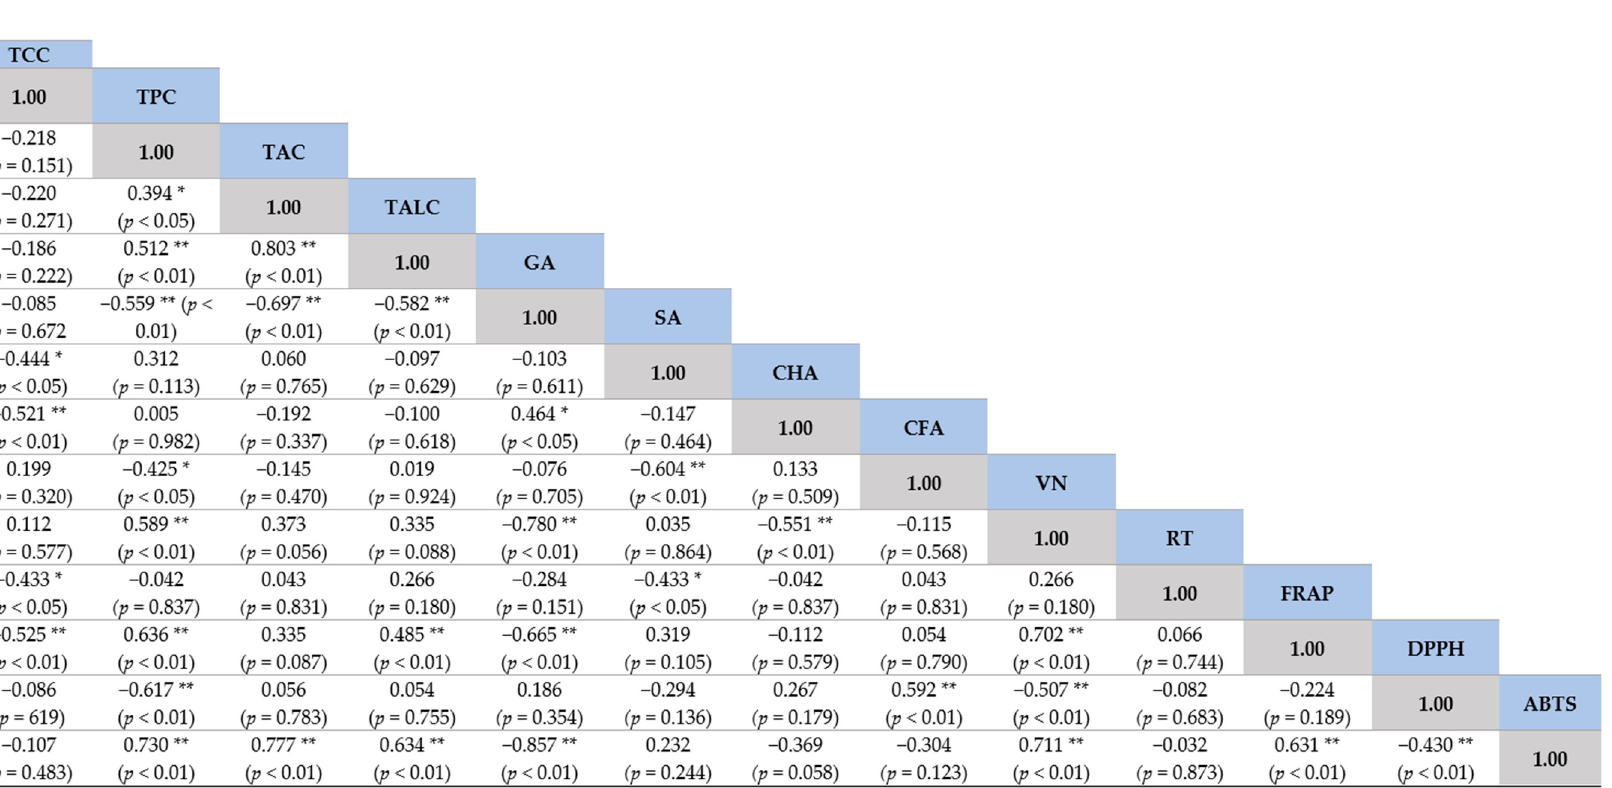
Figure 6. Correlation coefficient (r) between the phytochemicals (TCC, TPC, TFC, TALC, TAC, GA, SA, CHA, CFA, VN, and RT) in different sprouts with antioxidant capacity (DPPH, ABTS, and FRAP). If the r value is close to +1 or − 1, it indicates a strong positive relationship or an inverse relationship, respectively. If r is near 0, it indicates a weak or no relationship. * Correlation is significant at p < 0.05. ** Correlation is significant at p < 0.01. Abbreviation: TCC = total chlorophyll content, TPC = total phenolic content, TAC = total anthocyanin content, TALC = total alkaloid content, TFC = total flavonoid content, GA = gallic acid, SA = syringic acid, CHA = chlorogenic acid, CFA = caffeic acid, VN = vanillin, RT = rutin, DPPH = DPPH radical scavenging activity, FRAP = ferric-reducing antioxidant power, ABTS = ABTS radical scavenging activity.